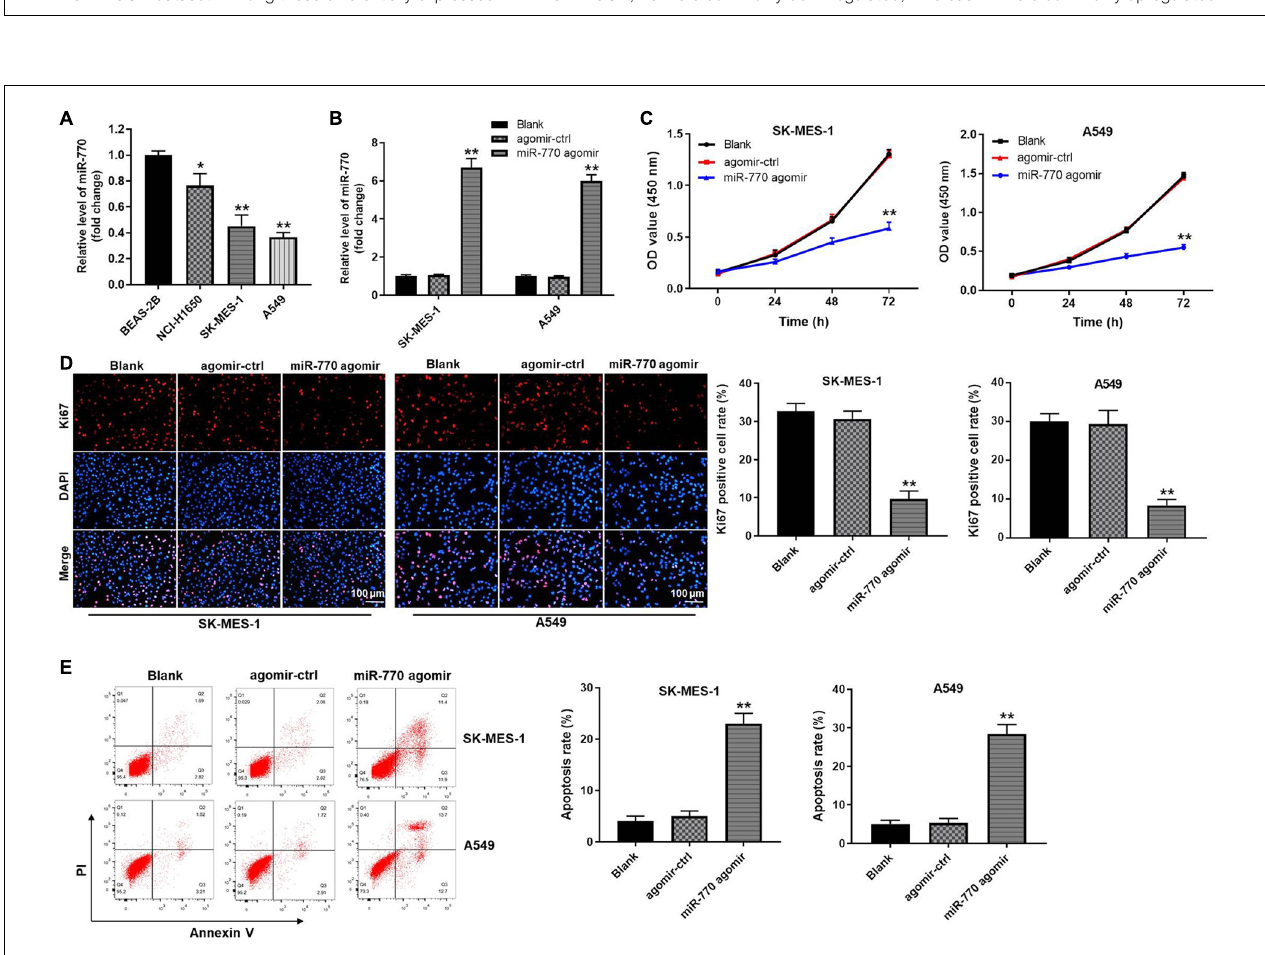
FIGURE 2 | MiR-770 agomir significantly inhibited the proliferation of NSCLC cells via inducing apoptosis. (A) The level of miR-770 in BEAS-2B, NCI-H1650, SK-MES-1 or A549 cells was detected by RT-qPCR. (B) SK-MES-1 or A549 cells were transfected with agomir-ctrl or miR-770 agomir. Then, the expression of miR-770 in NSCLC cells was tested by RT-qPCR. (C) The viability of NSCLC cells was tested by CCK-8 assay. (D) The proliferation of NSCLC cells was investigated by Ki67 staining. (E) The apoptosis of NSCLC cells was tested by flow cytometry. N = 3; ∗∗ P < 0.05 compared to control.